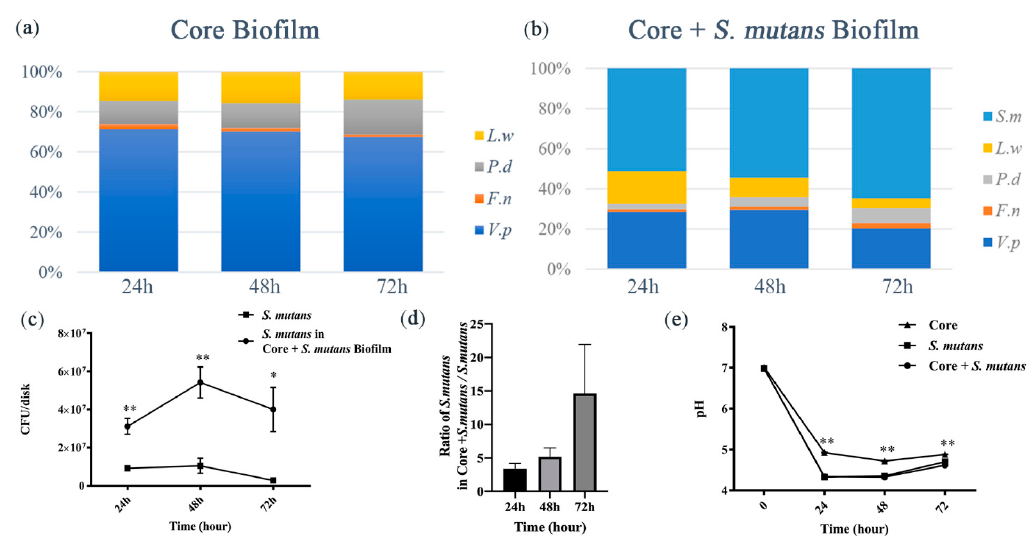
Figure 1. Composition of the biofilm and biofilm pH monitoring. ( a ) Composition of the core biofilm at 24 h, 48 h, and 72 h. ( b ) Composition of the Core + S. mutans biofilm at 24 h, 48 h, and 72 h. ( c ) S. mutans counting of the Core + S. mutans biofilm and S. mutans biofilm at 24 h, 48 h, and 72 h (n = 3). ( d ) Ratio of S. mutans in Core + S. mutans / S. mutans . ( e ) Medium pH of the biofilms at 24 h, 48 h, and 72 h (n = 3). Data are expressed as means ± standard errors. * p < 0.05; ** p < 0.01.